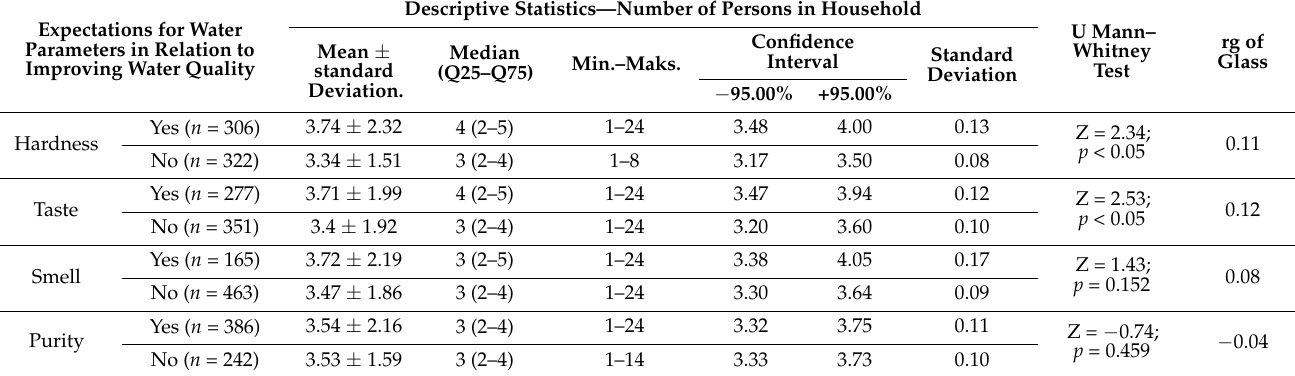
Table 5. Relationship between the number of people in the respondents’ household and their expectations of water parameters in relation to water quality